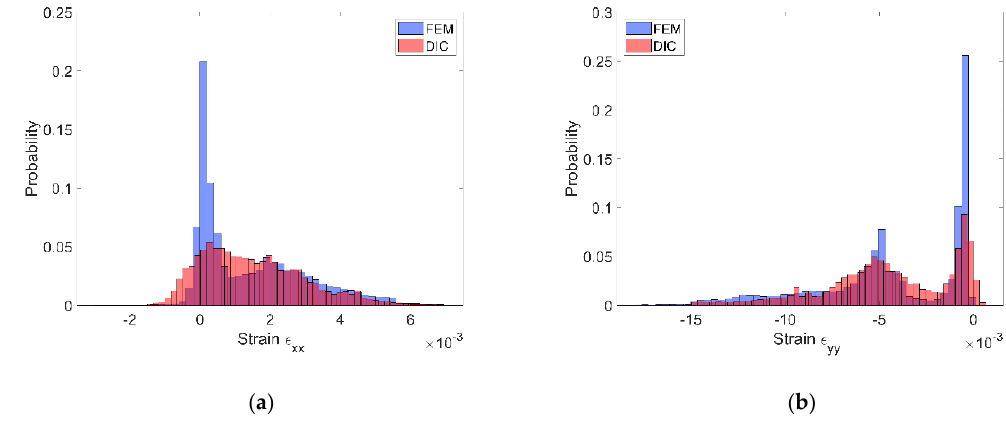
Figure 10. Distribution of the ε yy strain: ( a ) FE reference solution, ( b ) DIC analysis.